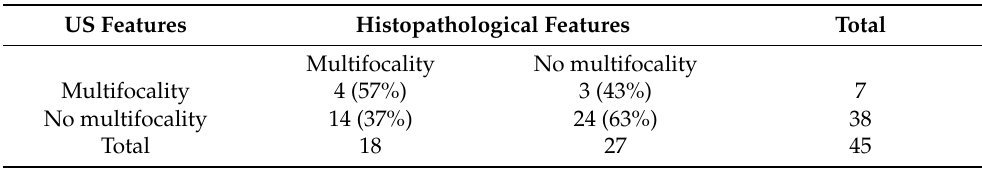
Table 2. Multifocality according to US and histopathological